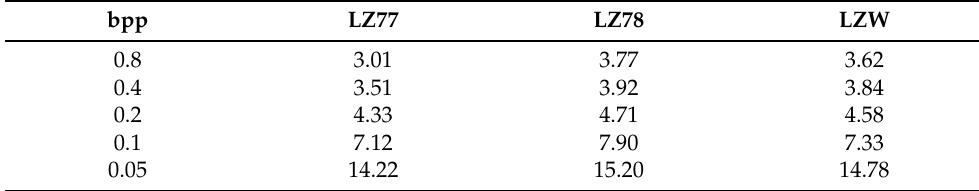
Table 3. Average absolute error for image horse and LZ-family coders.